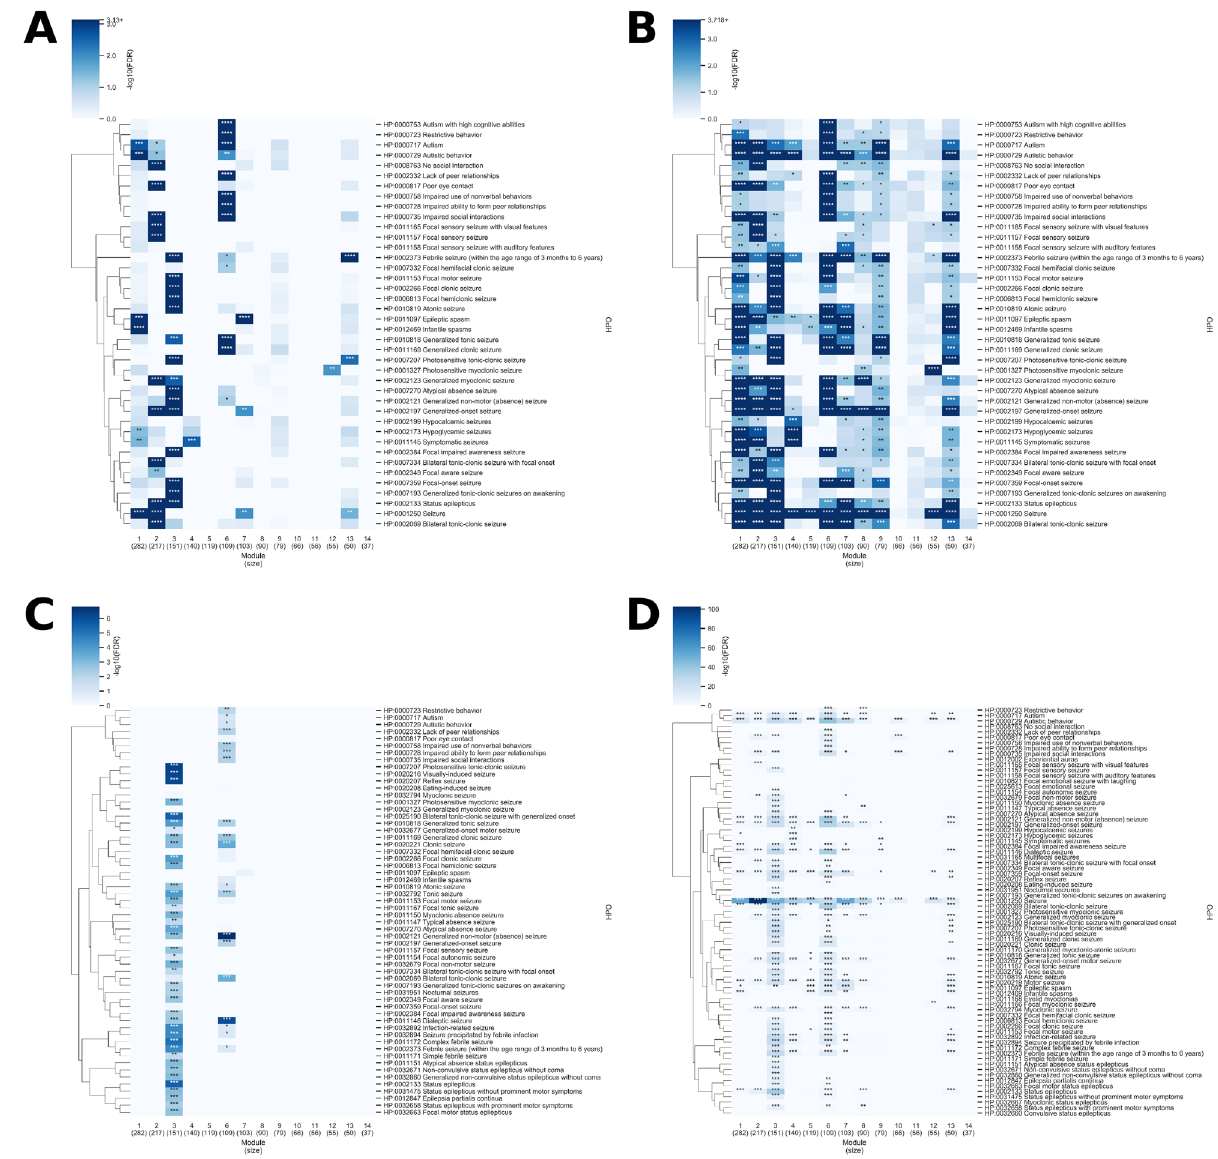
Figure 5. Enrichment analysis of epilepsy- and autism-related HPO terms for modules in the multiplex network. The enrichment of different epilepsy and autism phenotypes over the 14 largest modules in the epilepsy-autism multiplex network is shown. The first cluster of HPO terms represent autism phenotypes and the rest represent epilepsy phenotypes. Only HPO IDs with gene-HPO relationships in the Phen2Gene knowledgebase are shown. The p-value was determined by computing the mean gene-phenotype association score for each HPO ID over the genes in the module and comparing it to the mean of 10,000 trials using n genes, where n is the size of the module, randomly chosen from ( A ) the 1707 genes in the multiplex network or ( B ) all genes in the Phen2Gene knowledge base. ( C ) and ( D ) correspond to ( A ) and ( B ), respectively, except that the phenotype enrichment was calculated using annotated gene-HPO relationships from hpo.jax.org, The hypergeometric test was used to determine the p-value and the false discovery rate (FDR) is reported. For all plots, the false discovery rate (FDR) is reported since multiple HPO IDs were tested. “****” denotes FDR < 0.0001, “***” denotes FDR < 0.01, “**” denotes FDR < 0.05, and “*” denotes FDR < 0.1. The clustermap was generated using seaborn version 0.10.0 (https ://seabo rn.pydat a.org/). The linkage on the rows was generated based on the distance between HPO IDs in the HPO